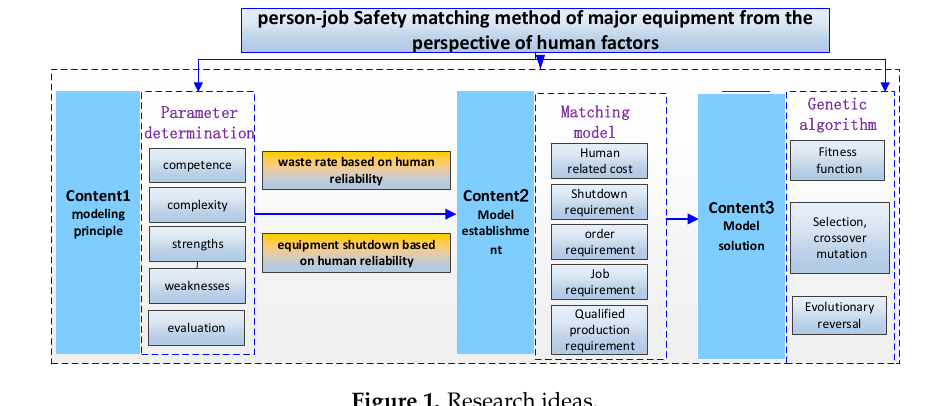
Figure 1. Research ideas. Table 1. Variable definitions.